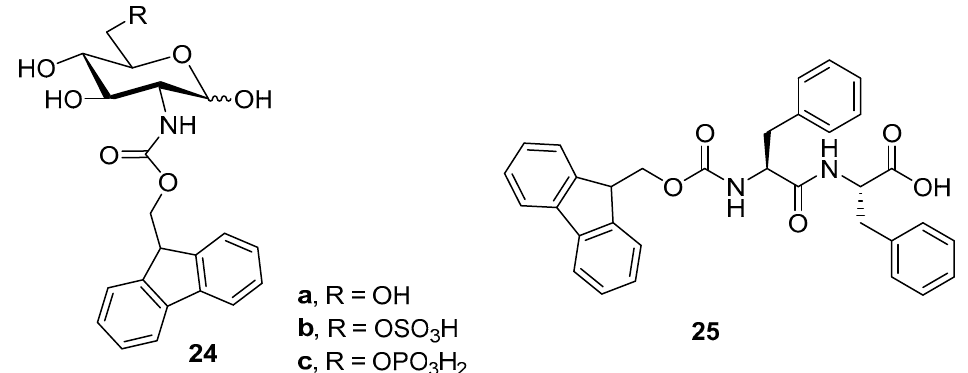
Figure 18. Structures of carbohydrate amphiphiles and a peptide amphiphilic molecule [59,60].